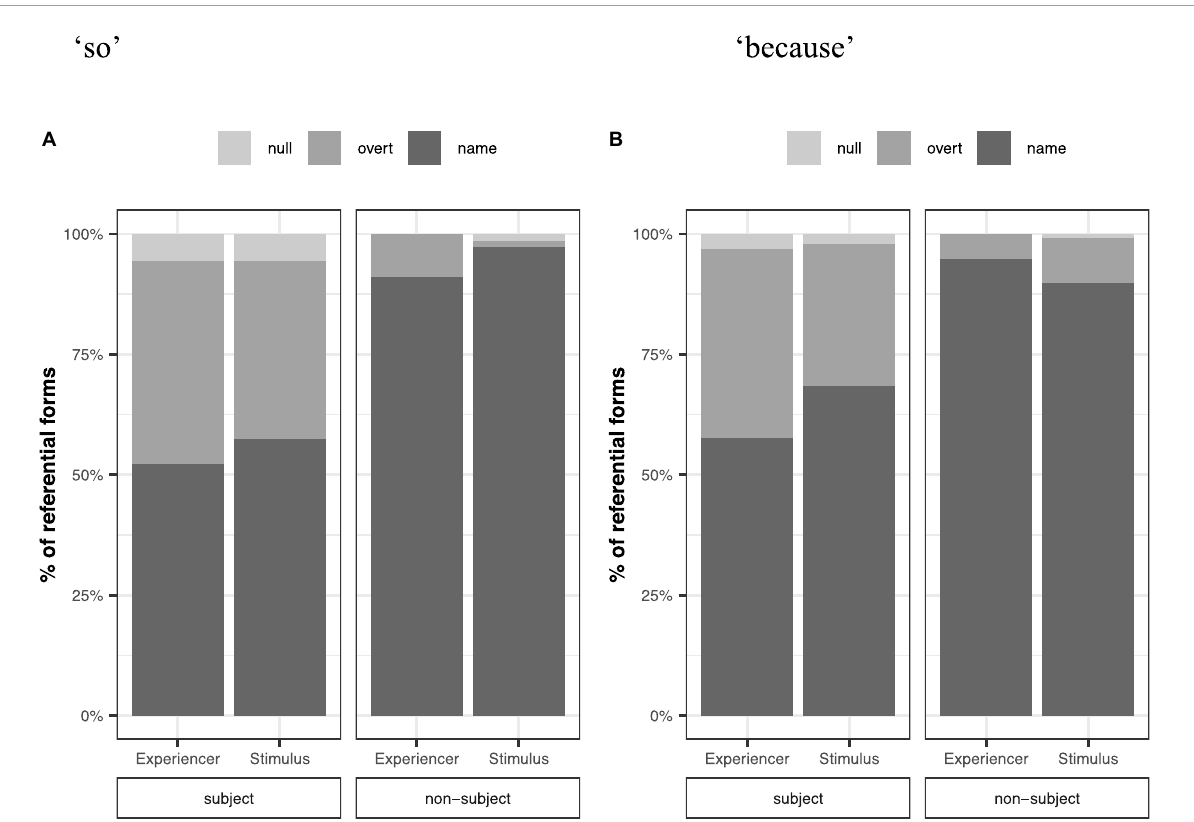
FIGURE3 Percentages of referential forms by grammatical role (subject vs. non-subject) and thematic role following “so” (A) and “because” (B) for IC